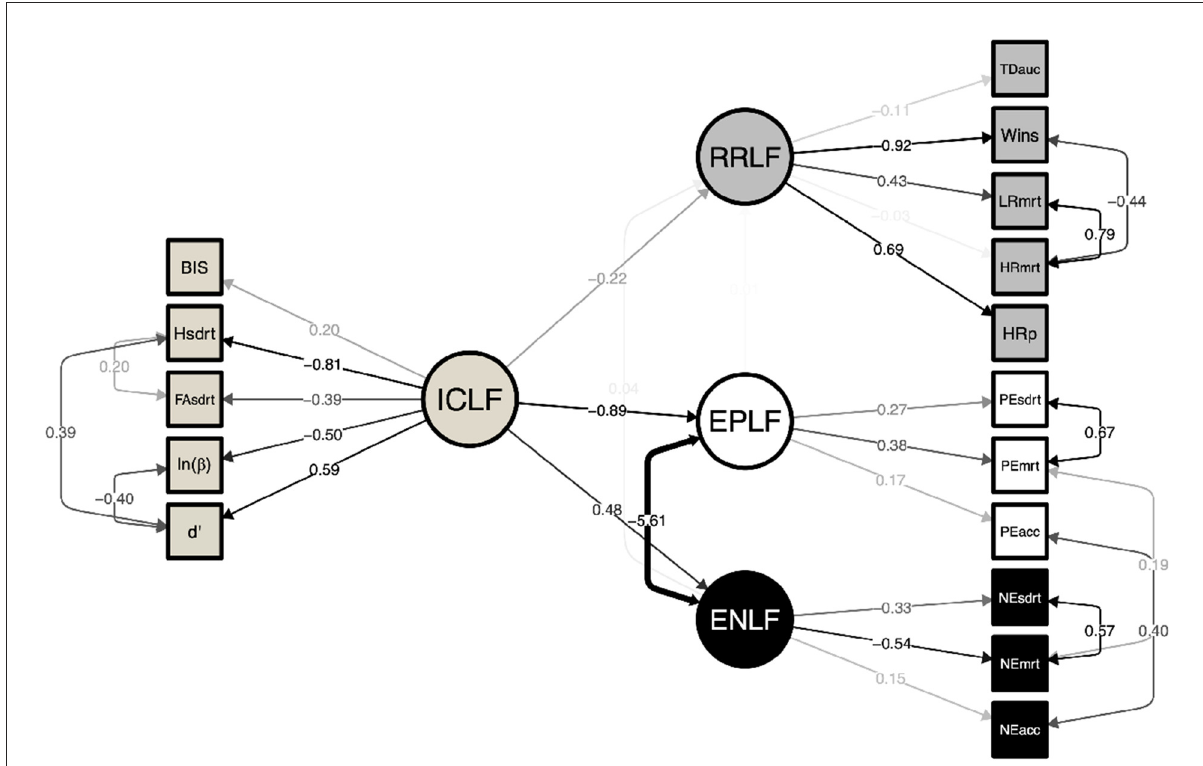
FIGURE2 Structural equation model of latent factors underlying inhibitory control (ICLF), risky reward processing (RRLF), and responsivity to positively (EPLF) and negatively salient emotional faces (ENLF; RMSEA = 0.047, TLI = 0.926, CFI = 0.945). Inhibitory control was observed to be a significant effector of lower risk taking ( p = 0.026) and responsivity to both negative ( p = 0.007) and positive ( p = 0.02) emotional faces. No significant relationship was observed between RRLF and EPLF/ENLF. The ENLF manifested as fast and accurate responses to negative emotions, whereas EPLF was an indicator of longer looking times leading to correct recognition. ICLF effected faster looking time to all emotions at the expense of recog- nizing happy face expressions. Paths are faded to indicate statistical significance and strength of association. Numerical edge labels provide standardized